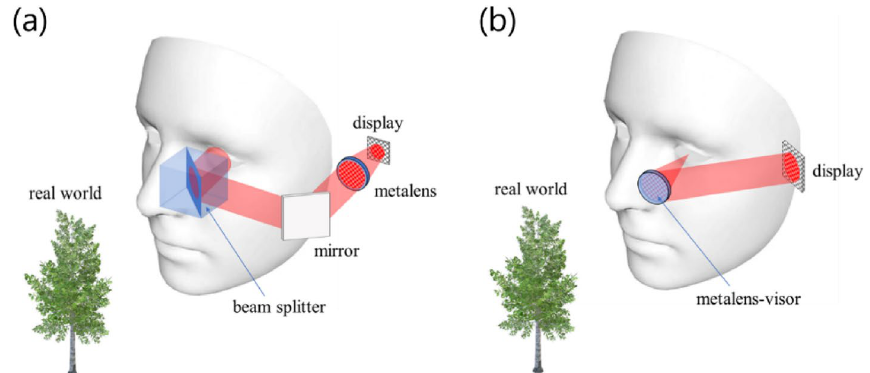
Fig. 1 Simplified schematic diagrams of near‑eye AR display systems based on ( a ) a traditional transmissive metalens and ( b ) a single piece see‑through reflective